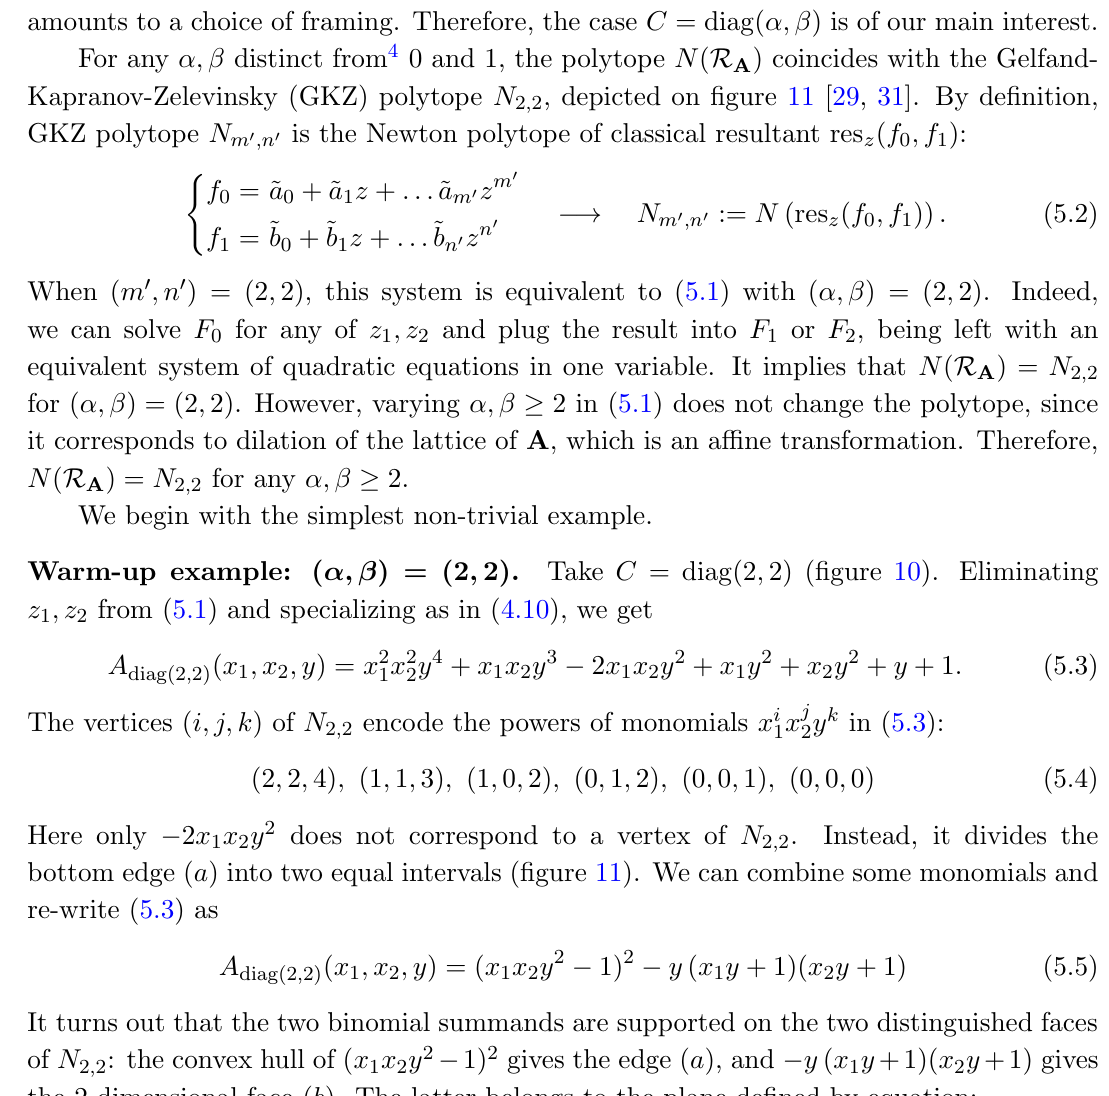
Figure 10 . Quiver with adjacency matrix C = diag(2 ;